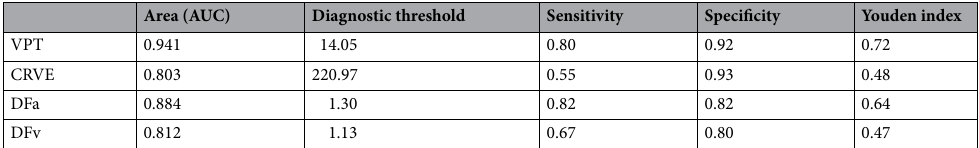
Table 3. AUC analysis of VPT and retinal vessel parameters. AUC area under the curve, VPT Vibration perception threshold, CRVE Central retinal vein equivalent, DFa Fractal dimension arterioles, DFv Fractal dimension